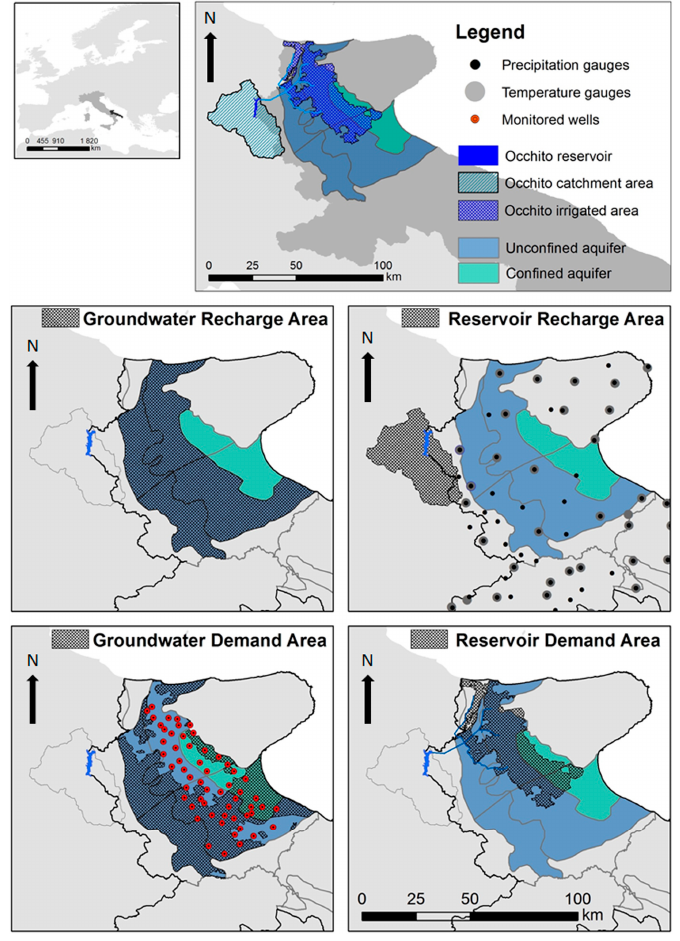
Figure 2. Case study. Upper panels: case study localizations. Center and Lower panels: groundwater recharge and demand areas as defined in Section 2. The Occhito reservoir, as well as, the considered unconfined/confined aquifer domains [37] are shown on each panel, while precipitation and temperature gauges are shown only in the reservoir demand area panel for a better visualization. Monitoring wells are shown in the groundwater demand area (refer to [19]).